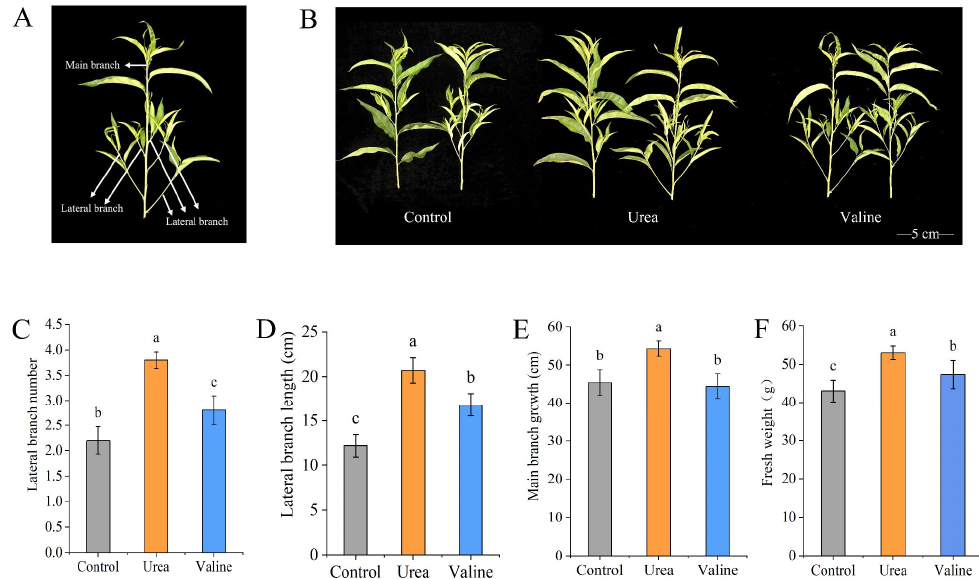
Figure 1. Effects of valine and urea on the growth of new shoots of peach trees: ( A ) Main branch and lateral branch distribution. ( B ) Growth of new shoots in different treatments. ( C ) Lateral branch number. ( D ) Lateral branch length. ( E ) Main branch growth. ( F ) Fresh weight. The error bar represents the standard deviation of the mean ( n = 3). The experiment was conducted on 1 July 2020 using a valine and urea solution at a concentration of 4 g · L − 1 . Different lowercase letters indicate significant differences among treatments (Duncan test, p < 0.05).